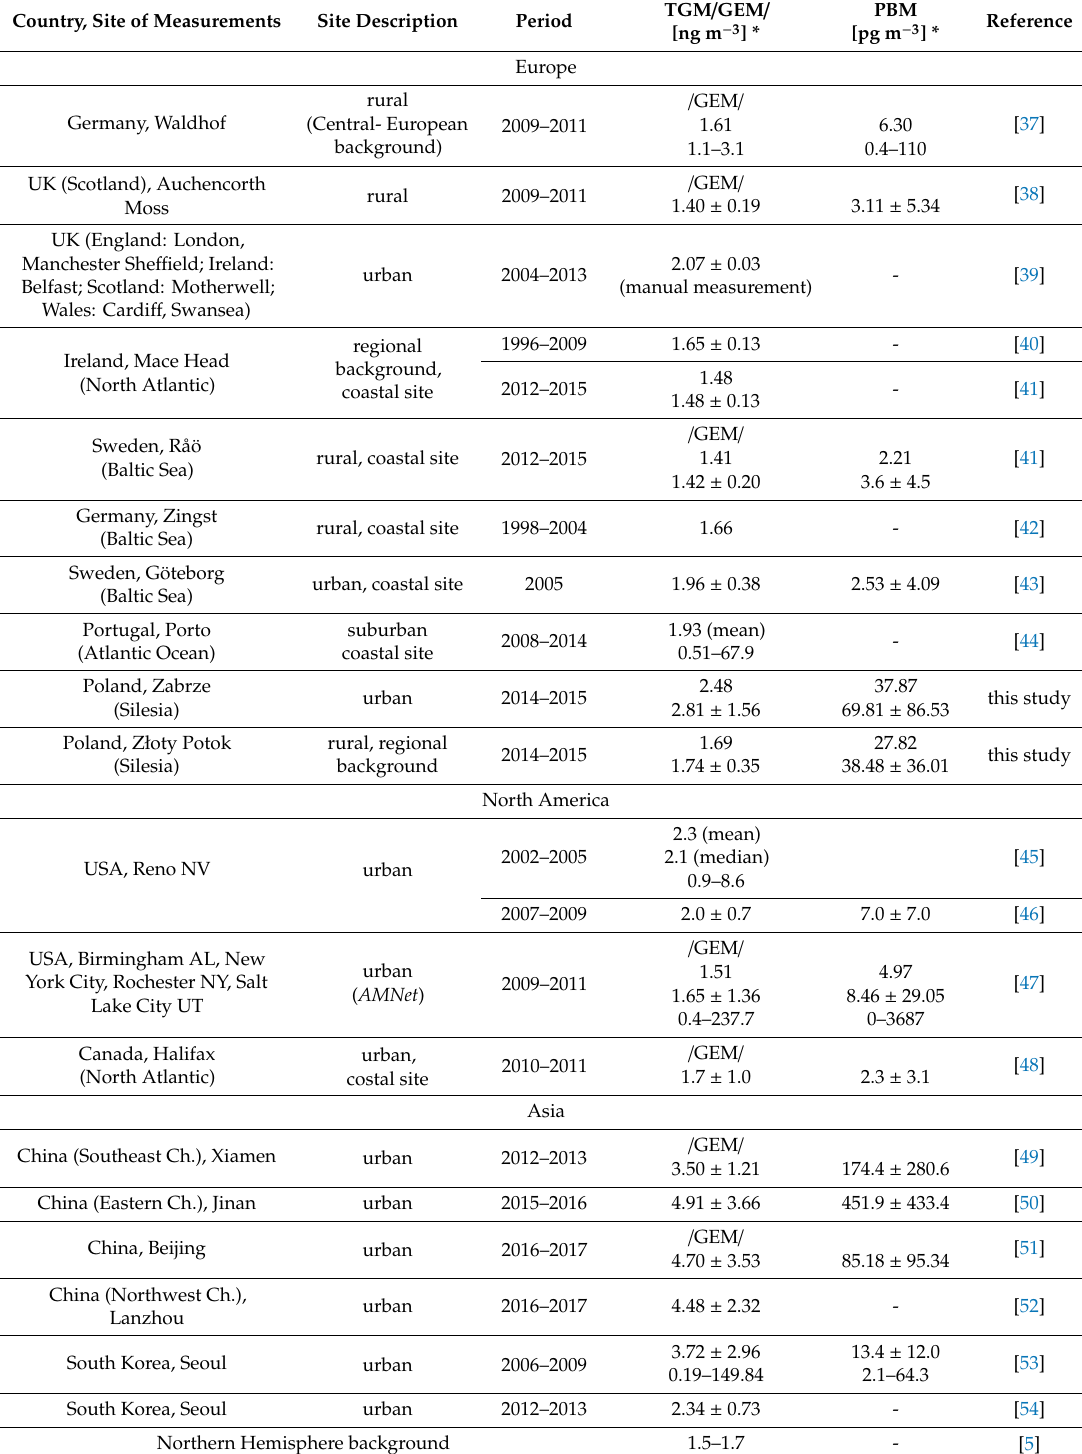
Table 3. Comparison of TGM and PBM concentrations in selected sites in Europe, North America, and